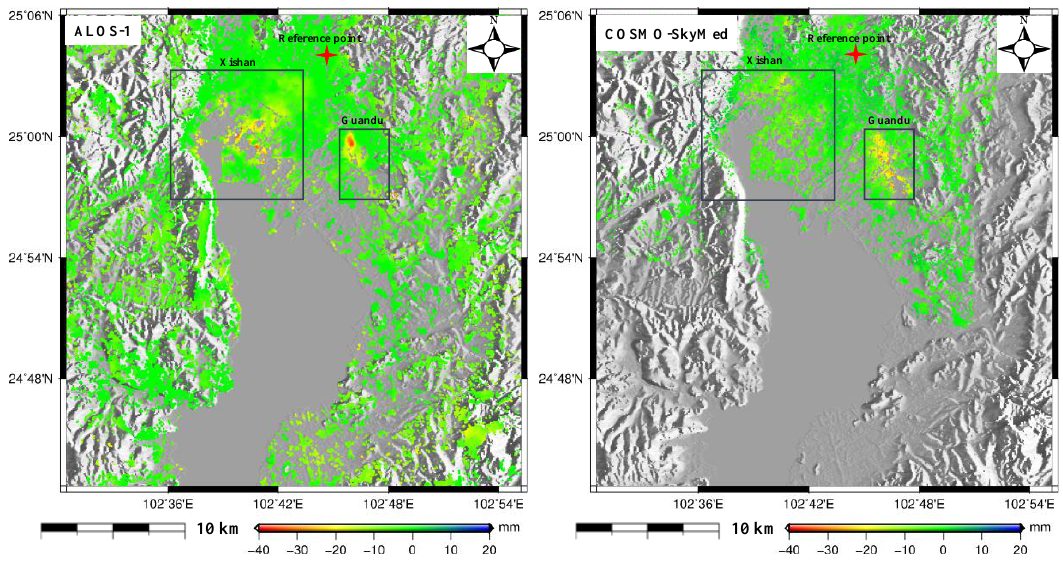
Figure 5. The annual deformation velocity maps from ALOS-1 (left) and COSMO-SkyMed (right) in this study. The red cross shows the reference point and the black rectangles denote the subsiding region.